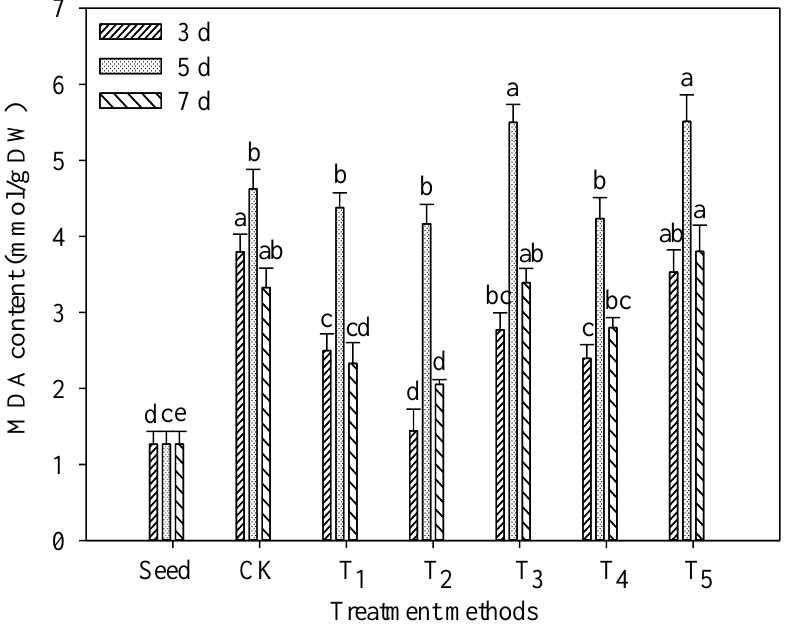
Figure 4. Effect of exogenous additives on MDA content in TB sprouts. Different lowercase letters indicate significant statistical difference ( p < 0.05).